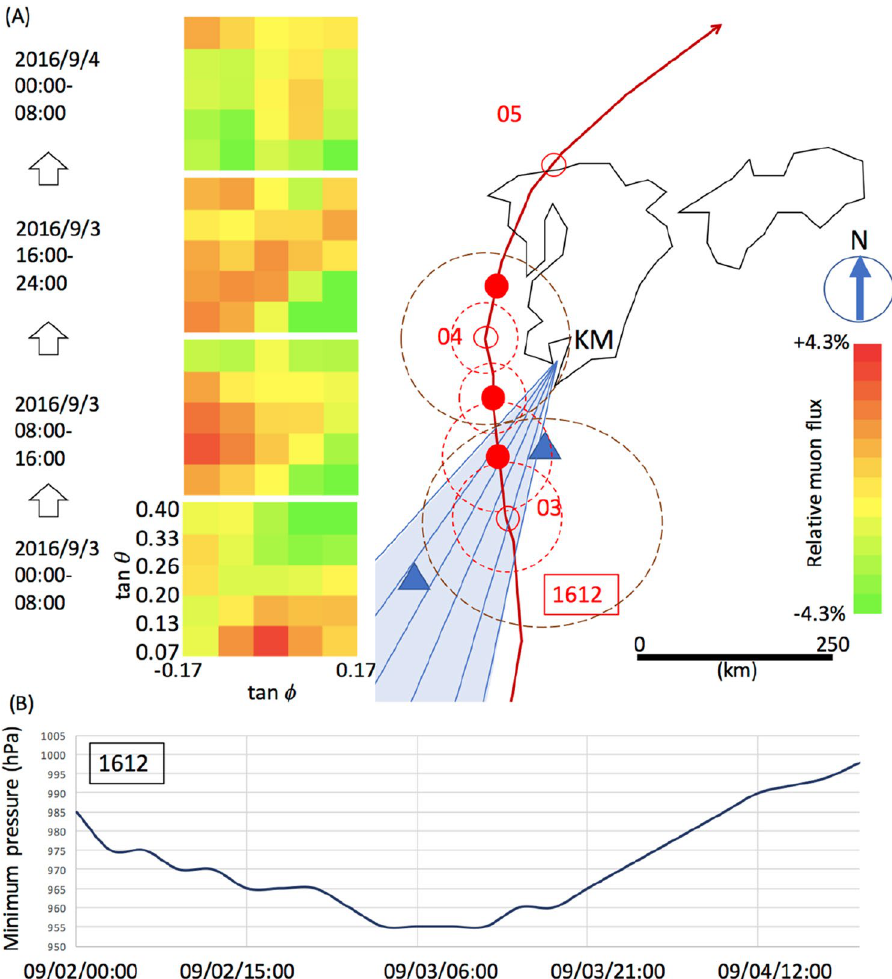
Figure 10. Time-sequential muographic images ( A ). The four images show the muon flux variations observed every 8 h within the period between 00:00 on September 3, 2016, and 08:00 on September 4, 2016. The horizontal width of these muographic images corresponds to the shaded area indicated on the map on the right side. The meteorological history of T-1612 is also shown. Triangular symbols indicate the atmospheric pressure gauge stations (Yakushima Station is in the north, and Naze Station is in the south). The symbol KM indicates the location of Kagoshima Muograph. The red numbers and red hollow circles respectively indicate the date and the position of the T-1612’s center. The filled red circles indicate the T-1612 positions at 08:00, 16:00 on September 3, and 08:00 on September 4. The red dashed circles indicate the storm area (wind speed > 25 m s −1 ) at 00:00, 08:00, 16:00, and 24:00 on September 3, and the brown dashed circles indicate the strong wind area (wind speed > 15 m s −1 ) at 00:00 and 24:00 on September 3. The time-dependent variations of the minimum pressure of T-1612 are also shown ( B ). HKMT drew the map with Microsoft PowerPoint software and the image with Microsoft PowerPoint software and holds the